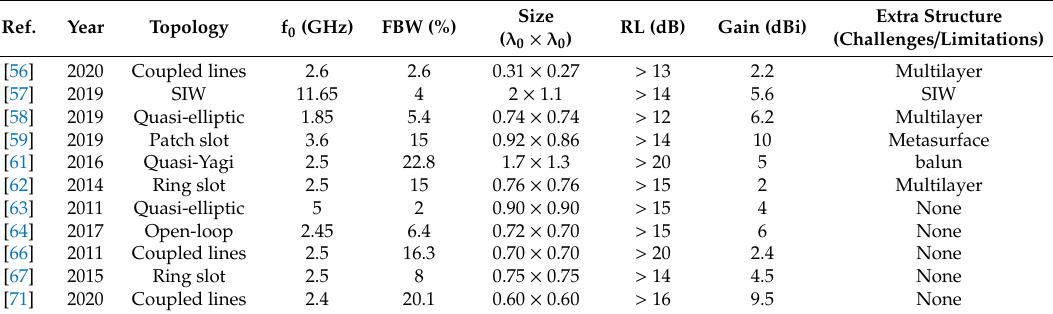
Table 3. Comparison between the presented filter–antenna designs.